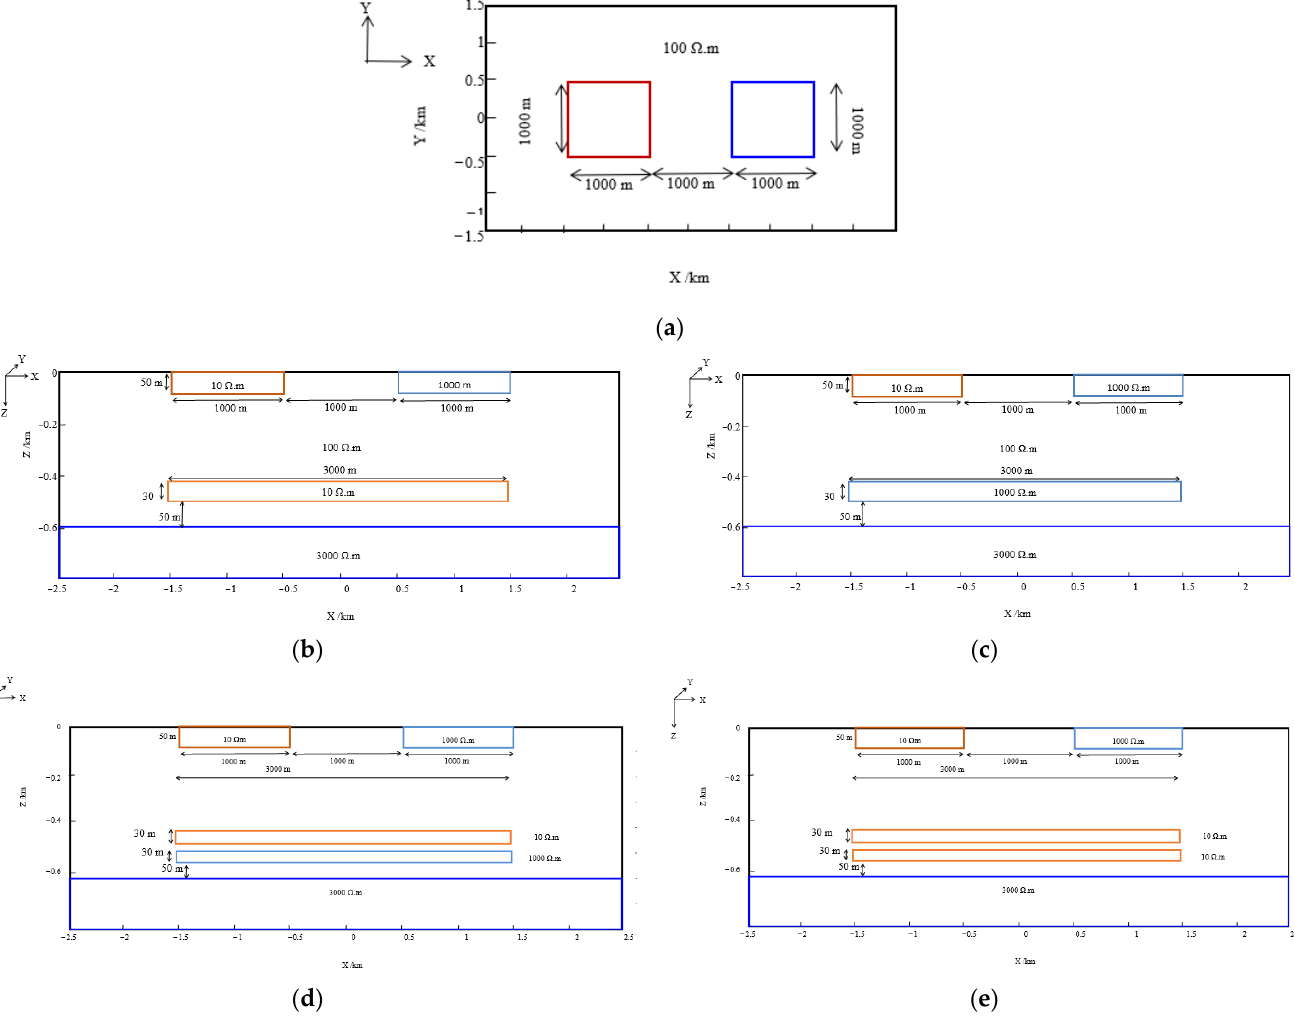
Figure 4. Profiles of the 3D synthetic models of single- or double-target layers from different perspectives. ( a ) Schematic diagram of XOY profiles at Z = 0 for both single-target models; ( b ) XOZ profile at Y = 0 for the low resistive target layer model; ( c ) XOZ profile at Y = 0 for the high resistive target layer model; ( d ) double-target layer model with the second target as high resistive; ( e ) double-target layer model with the lower layer set as low